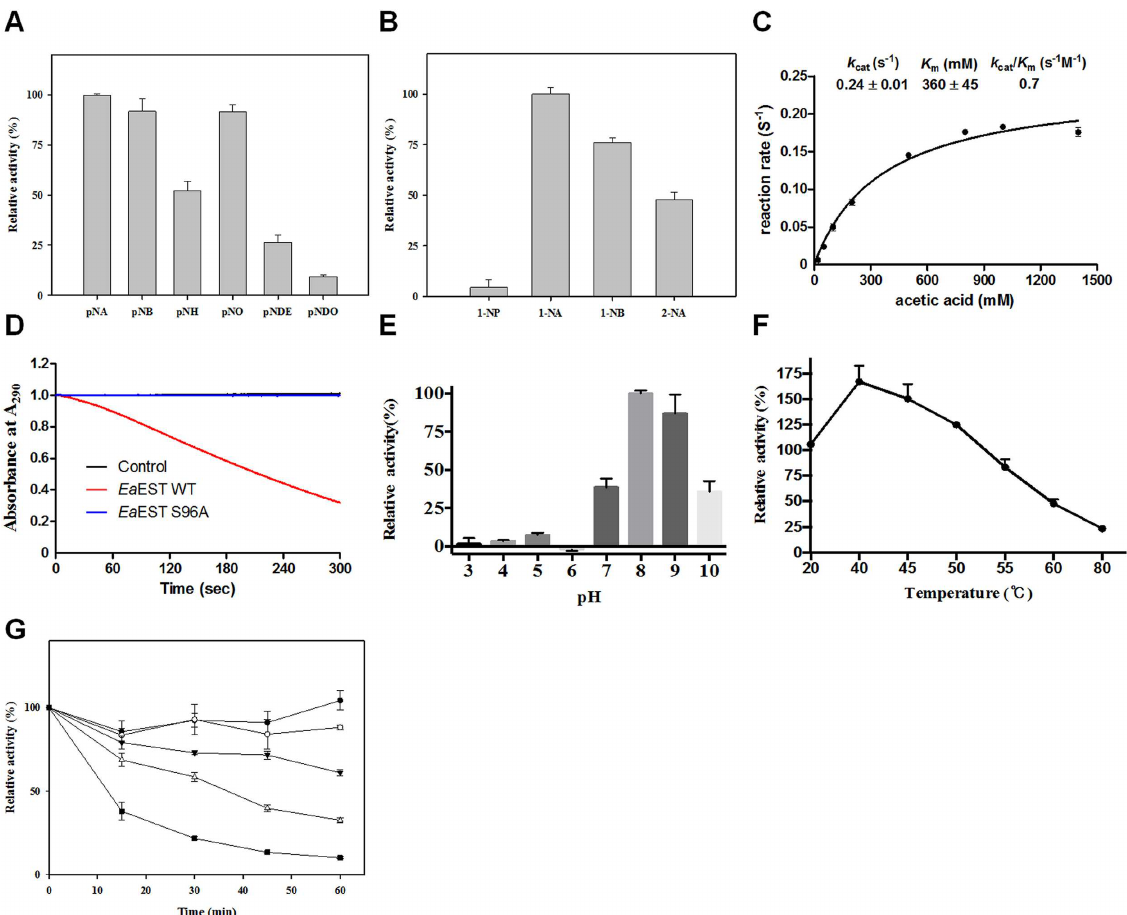
Fig 5. Enzyme activity of Ea EST. (A) The substrate profiles of Ea EST were determinedusing different p -NP esters (A) and naphthylderivatives(B). (C) The reaction rate of acetic acid perhydrolysis catalyzed by wild-type Ea EST. Perhydrolase activities were measuredat pH 5.5 at 25˚C. Kinetic constants were obtained by varyingthe concentration of acetic acid. (D) Specific activities for acetic acid perhydrolysis catalyzedby wild-type Ea ESTand the S96A mutant. (E) pH stability of Ea EST. The pH dependence of hydrolysis of p -NAby Ea EST was measuredat 25˚C. (F) Effect of temperature on the residual activity of Ea EST. (G) Thermostability of Ea EST. Residualactivities are expressed relativeto the originalactivity duringincubationat 0, 20, 40, 45, and50˚C. The results are the meanof three individualexperiments.